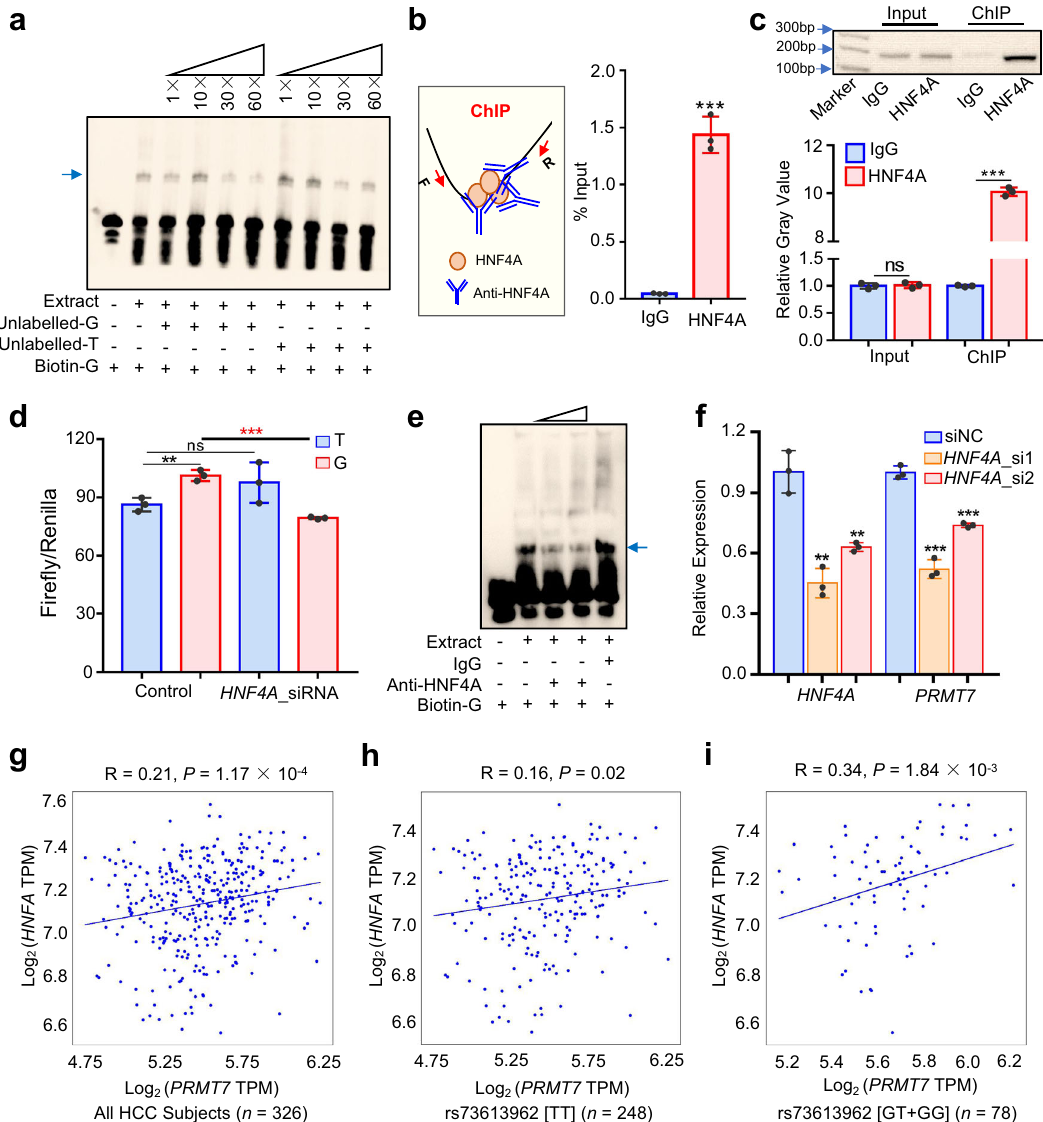
Fig. 4 The risk allele G of rs73613962 enhances the binding ability of transcription factor HNF4A to promote PRMT7 expression. a The result of the competitive EMSA. The binding af fi nity of protein to DNA oligos is demonstrated by adding unlabeled-G or unlabeled-T to the reaction. The light blue arrow indicates the protein-biotin-G-oligo complexes. This experiment is replicated two times at least and similar results are observed. b The enrichment of HNF4A on the rs73613962-containing region examined by ChIP. The left panel shows the diagram for HNF4A-ChIP. The antibody of HNF4A recognizes and binds to HNF4A; thus, the DNA sequence bound by HNF4A is pulled down from the fragmented chromatin. Then, the enriched DNA sequence is detected by the following qPCR as shown in the right panel. P = 0.0001 in HNF4A compared to IgG. c ChIP-PCR results. The agarose gel electrophoresis of PCR products for Input and ChIP, respectively, in the above panel. Light blue arrows indicate the marker bands. Source data are provided as a Source Data fi le. The relative gray value of each PCR band is analyzed using ImageJ in the bottom panel. P = 0.7769 and P < 0.0001 in HNF4A compared to IgG in Input and ChIP, respectively. d The dual-luciferase assay of enhancer activity for the enhancer-T and enhancer-G before and after the downregulation of HNF4A . P = 0.0046 in Enhancer-G compared to Enhancer-T without HNF4A knockdown, and P = 0.1493 and P = 0.0002 in Enhancer-T or Enhancer-G with HNF4A knockdown to Enhancer-T or Enhancer-G without HNF4A knockdown, respectively. e The result of the blocking EMSA of HNF4A. The amount of anti- HNF4A antibody in lane 3 and lane 4 is 1 μ g and 2 μ g, respectively. The IgG amount in lane 5 is 2 μ g. The light blue arrow indicates the HNF4A-biotin-G- oligo complexes. We repeat this experiment two times at least and always observe the similar results. f qPCR detection of HNF4A and PRMT7 expressions after the downregulation of HNF4A in cells through two siRNAs. For detection of HNF4A expression level, P = 0.0017 and 0.0037 in HNF4A_small interfering RNA (HNF4A_si)1 or HNF4A_si2 compared to small interfering RNA negative control (siNC), respectively. For detection of PRMT7 expression level, P = 0.0001 and P = 0.0002 in HNF4A_si1 or HNF4A_si2 compared to siNC, respectively. All the above experiments were conducted in the QGY- 7703 cell line ( a – f ). g – i The correlation of PRMT7 and HNF4A expressions showed in all HCC subjects ( g ), and subjects with the rs73613962 TT homozygote ( h ), or rs73613962 G allele carriers ( i ) in TCGA LIHC. TPM, transcripts per million. Values are expressed as the mean ± SD, n = 3 in b – d , and f . ‘ ns ’ means not signi fi cant; ** and *** mean P values less than 0.01, and 0.001, respectively (two-sided student ’ t